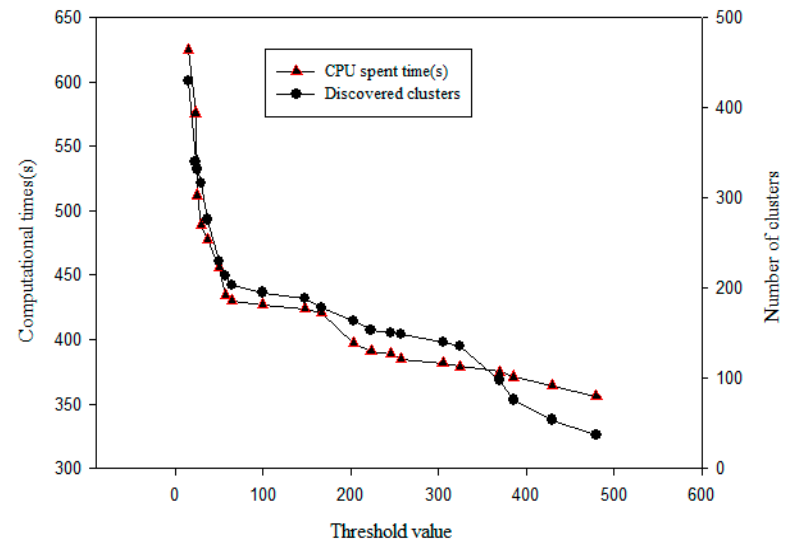
Figure 15. Speed comparison of stream clustering.